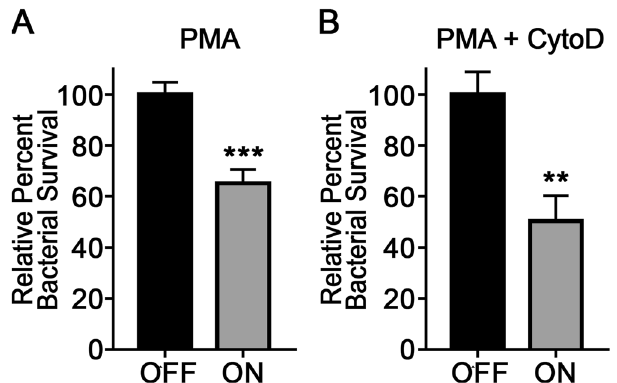
Figure 4. The modA2 locked ON variant was more sensitive to killing by human neutrophils. NTHI were incubated with human neutrophils that had been activated by addition of PMA without ( A ) or with ( B ) cytochalasin D pretreatment. After 30 minutes, the relative percent survival was calculated by comparison of viable (CFU) modA2 locked ON to modA2 locked OFF. ( A ) modA2 locked ON had significantly reduced survival in the presence of activated neutrophils compared to modA2 locked OFF, *** P < 0.001, unpaired t-test. ( B ) When cytochalasin D was used to prevent phagocytosis modA2 locked ON still had significantly reduced survival compared to modA2 locked OFF, ** P < 0.005, unpaired t-test. The modA2 ON status provided less resistance to killing by neutrophils compared to the modA2 OFF